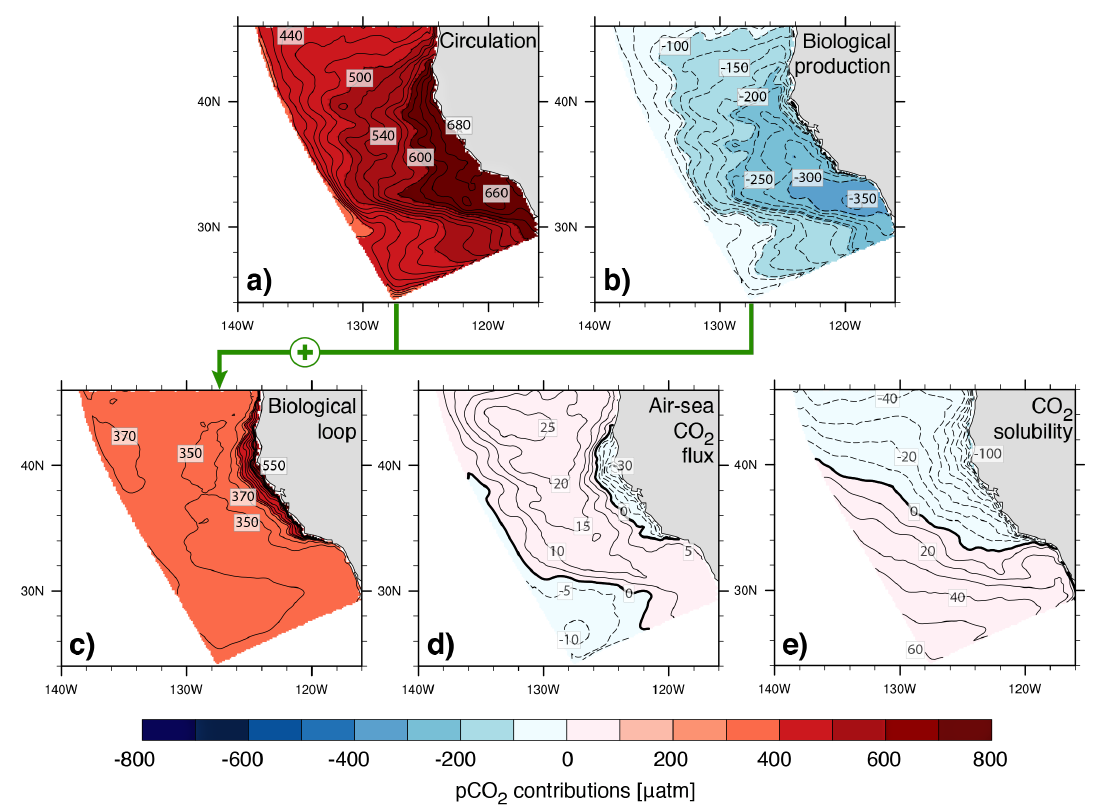
Fig. 7. Contributions of ocean circulation (a) , biological production (b) , air–sea CO 2 flux (d) and CO 2 solubility (e) to annual mean p CO 2 as simulated in the control simulation. Panel (c) represents the contribution of the biological loop, i.e. the sum of (a) and (b) (indicated by the green line). Positive contributions are displayed as solid lines, negative contributions as dashed lines.